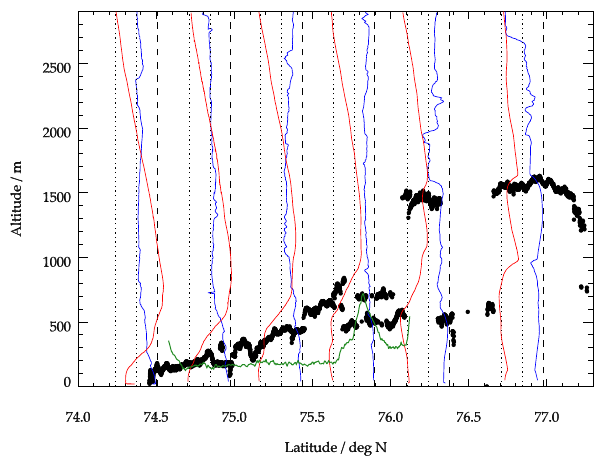
Fig. 5. Illustration of the flight on 17 May 2010. Remote sensing was performed at 3100m altitude (the top border of the plot), fly- ing southward from 09:00 to 10:22UTC. After the descent, in-situ observations were performed northward along the green line from 10:39 to 11:21UTC. Cloud top as detected by the lidar is indicated in black. Cloud bottom was at the ocean surface. Six dropsondes were launched, their profiles are drawn in red (temperature) and blue (relative humidity). Each drop-sonde profile is marked with one dashed and two dotted lines; the dashed lines are placed at the location of the launch, and also represent a temperature of 12 ◦ C and 100% RH. The central dotted lines show 6 ◦ C and 50%, the left dotted lines show 0 ◦ C and